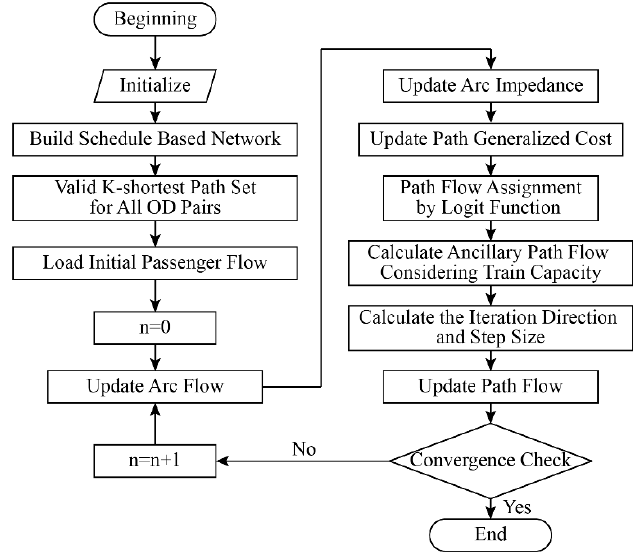
Figure 6. The solution approach of improved MSA method.